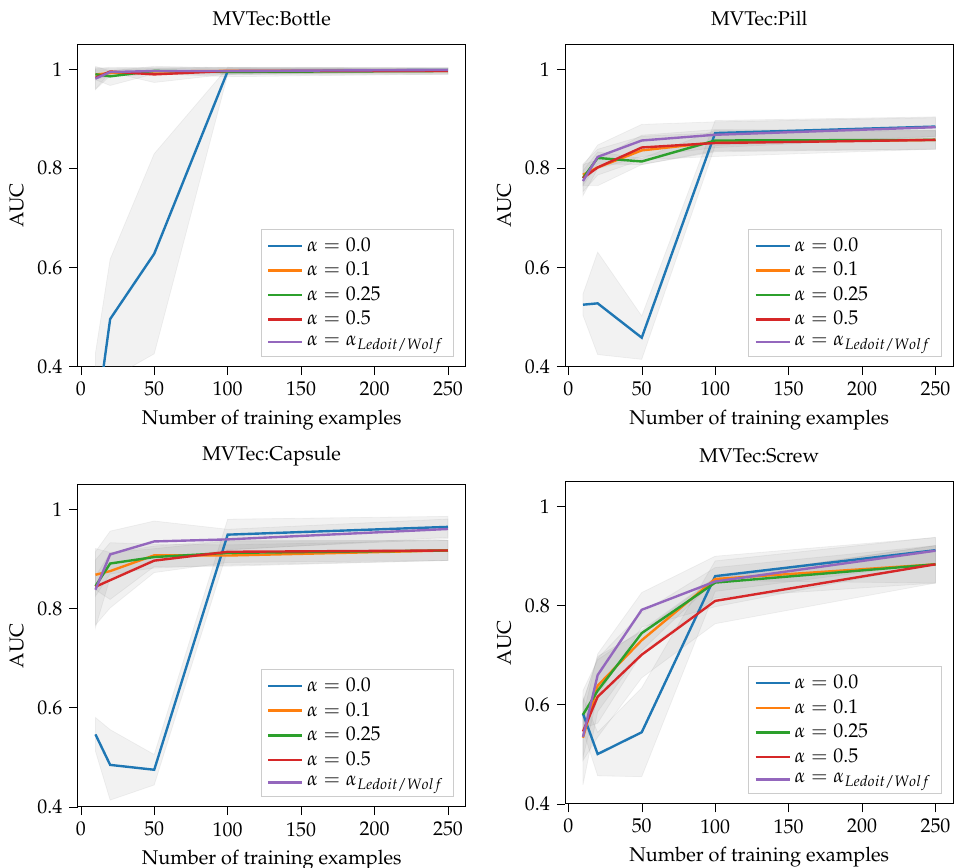
Figure 4. Impact of the the covariance shrinkage factor α on novelty detection performance. We selected four representative classes from the MVTec dataset [7] for evaluation. Due to the high dimensionality of the covariance matrix ( D = 6800), the effect of the shrinkage factor is largest when the number of training examples is small. The Ledoit–Wolf shrinkage α Ledoit / Wolf varies across experiments between [ 0.01,0.1 ] and clearly improves the average